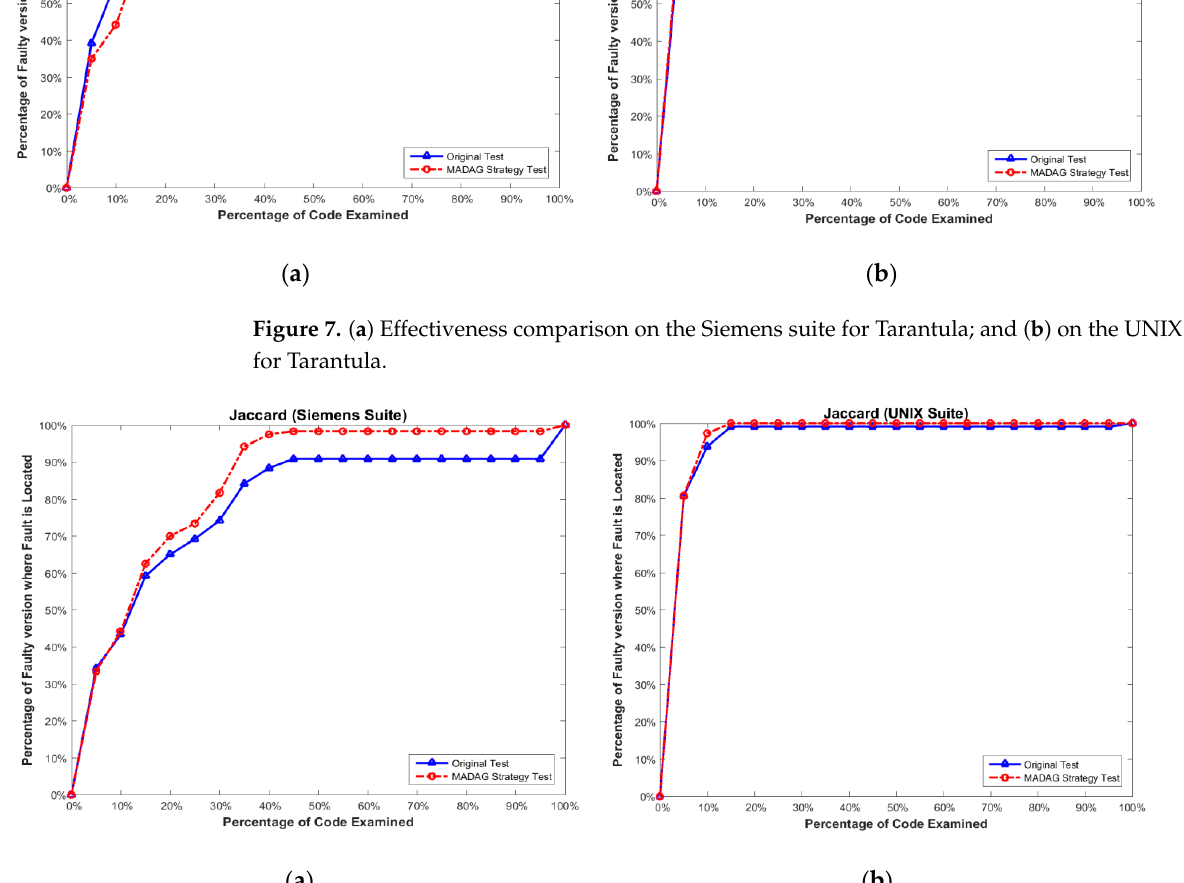
Figure 8. ( a ) Effectiveness comparison on the Siemens suite for Jaccard; and ( b ) on the UNIX suite for Ochiai.